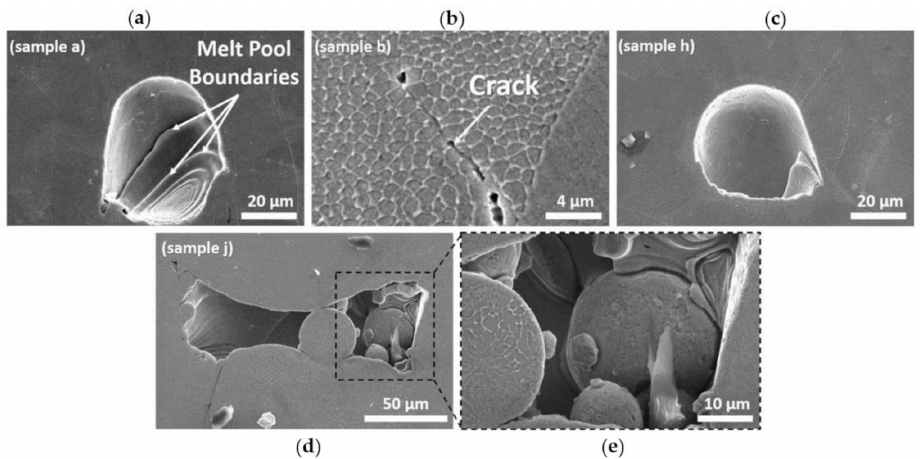
Figure 10. SEM images of defects: ( a ) void with melt-pool boundaries in the sample a, ( b ) a crack in the sample b, ( c ) entrapped gas pore in the sample h, ( d , e ) unmelted powders in the sample j. Unmelted regions that belong to the sample j are shown more accurately in Figure